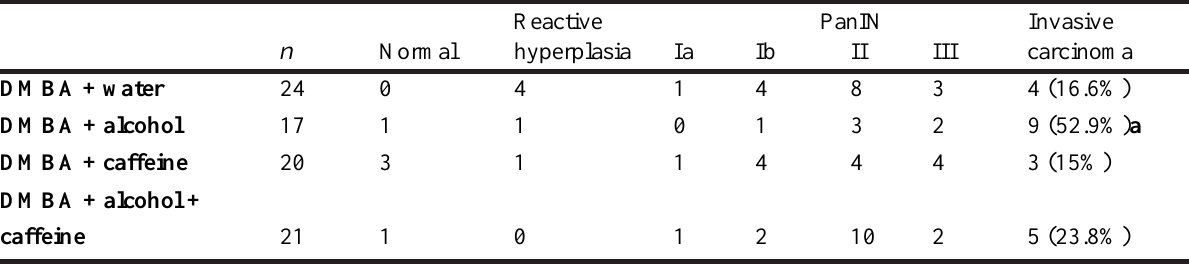
TABLE 3 - Frequency of histological diagnoses in the different groups Reactive PanIN Invasive n